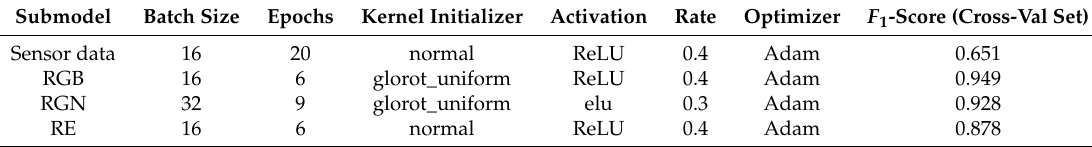
Table 3. Hyperparameters and F 1 -score for each generated